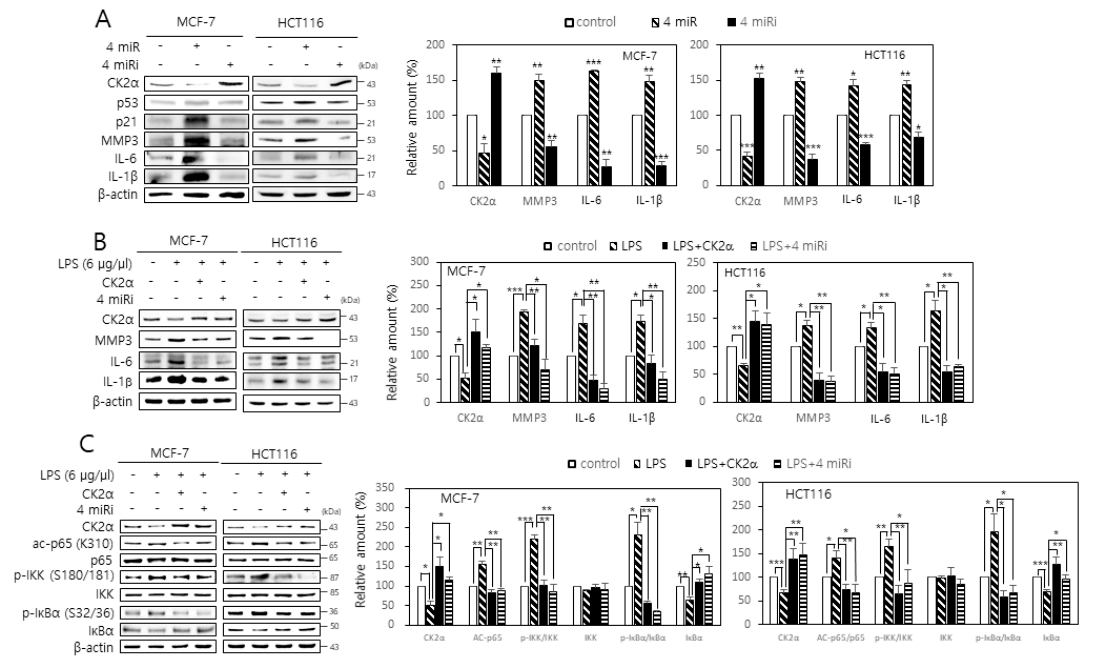
Figure 5. Antisense inhibitors of miR-186, miR-216b, miR-337-3p, and miR-760 attenuate the induction of senescence-associated secretory phenotype (SASP) factors by lipopolysaccharide (LPS). ( A ) MCF-7 and HCT116 cells were transfected with the 4 miRs (miR-186, miR-216b, miR-337-3p, and miR-760) or the 4 miRi. ( B and C ) Cells were treated with LPS (6 μ g/ μ L) in the presence or absence of the 4 miRi or pcDNA3.1-HA-CK2 α for 2 days. The level of each protein was determined by immunoblot analysis using specific antibodies ( left ). Representative data from three independent experiments are shown. β -Actin was used as a control. Graphs represent the quantitation of p-AKT, IKK, and I κ B α relative to β -actin and that of p-IKK and p-I κ B α relative to the unphosphorylated proteins ( right ). Data are mean ± SEM. * p < 0.05; ** p < 0.01; *** p < 0.001.